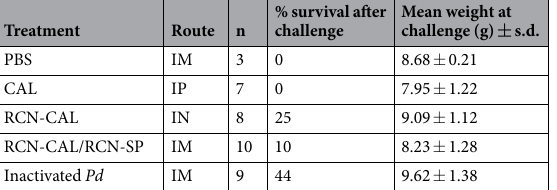
Table 1. Mean weight (in grams) of Myotis lucifugus that received various treatments prior to challenge with Pseudogymnoascus destructans (Pd) and post-challenge survival. Treatments included phosphate buffered saline (PBS) as a negative control, calnexin (CAL) protein, raccoon poxvirus (RCN) expressing CAL, RCN expressing CAL and RCN expressing serine protease (SP) in combination, and inactvated Pd , administered via intramuscular (IM), intraperitoneal (IP), or intranasal (IN)